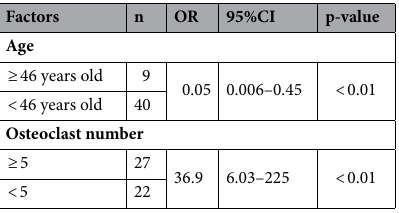
Table 3. The multivariate analysis for predicting the good response of chemotherapy. OR :Odds ratio, CI : Confidence intervals.